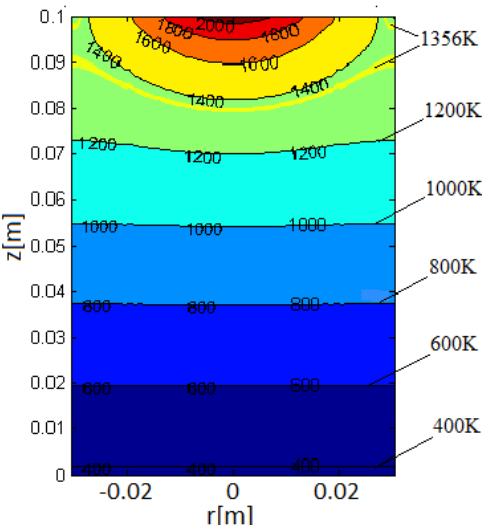
Figure 5. Temperature distribution in vertical cross-section of Cu cylindrical sample. The = 1356 K) is the liquid/solid boundary in the metal. solid yellow curve ( T melt